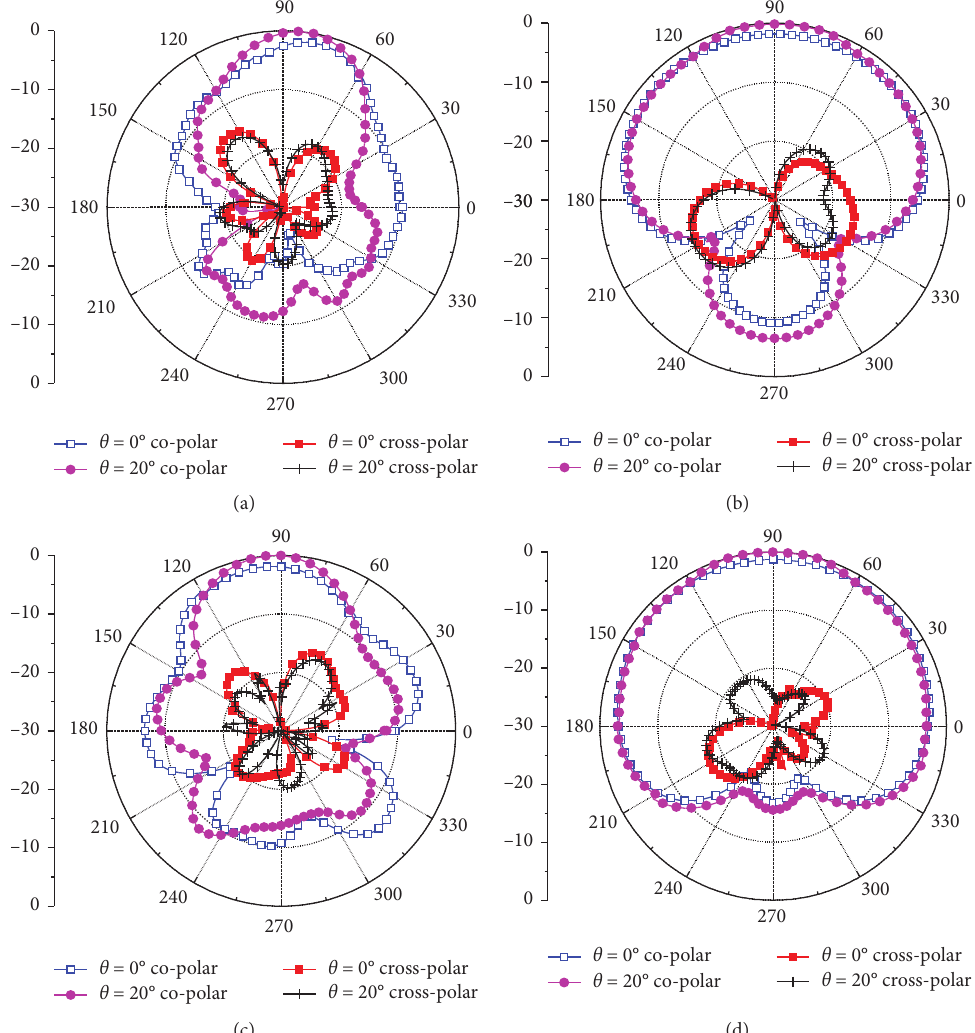
Figure 9: Simulated radiation patterns with the feed line tilted by 20 ° and 0 ° : (a) 2.4 GHz, E-plane, (b) 2.4GHz, H-plane, (c) 5.5 GHz, E- plane, and (d) 5.5 GHz,